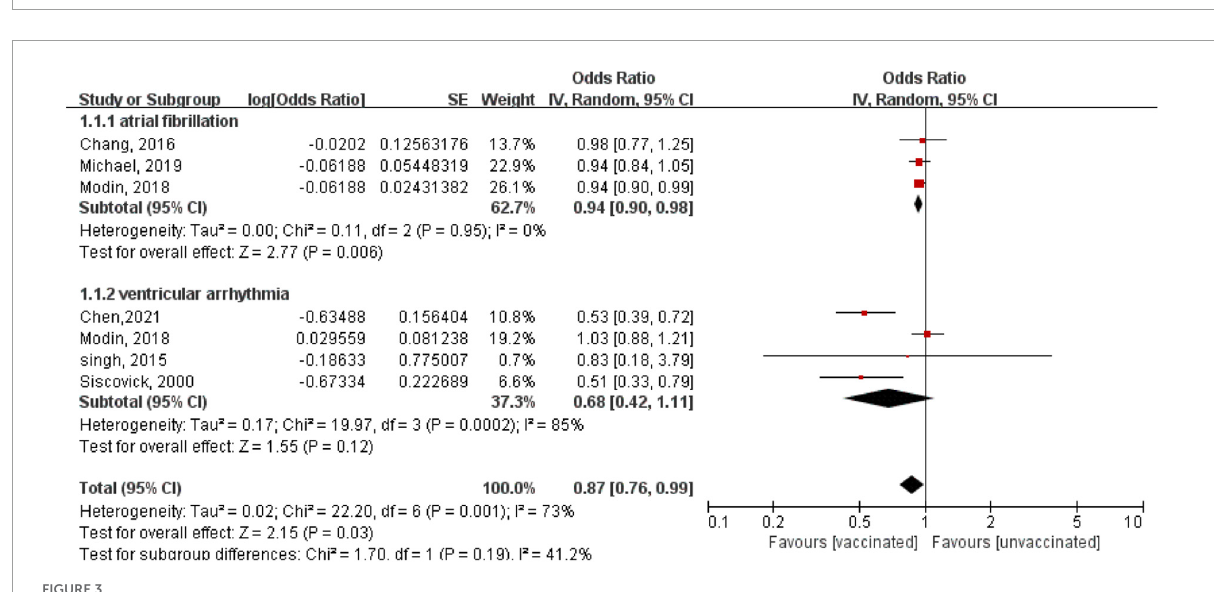
FIGURE3 Forest plot for the association between influenza vaccination and the risk of arrhythmia, stratified by the type of arrhythmia. Atrial fibrillation, ventricular arrhythmia.